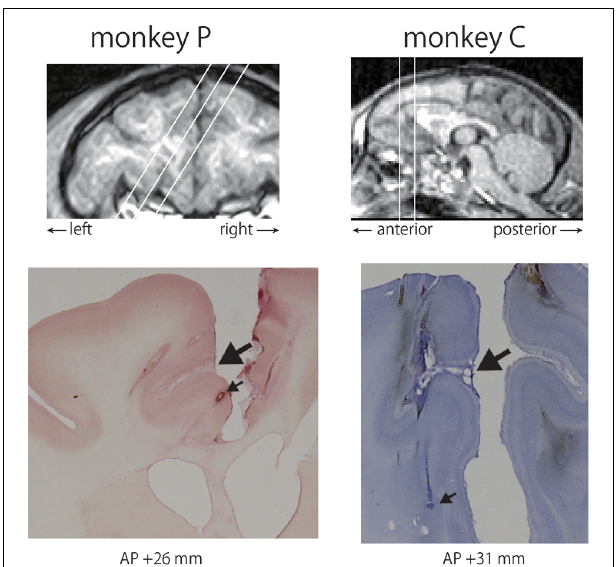
was located vertically based on T1-weighted MRI images (top). Locations of recording sites were determined using electrolytic lesions as reference points. A large arrow indicates the cingulate sulcus and a small arrow represents a lesion in each monkey (bottom).